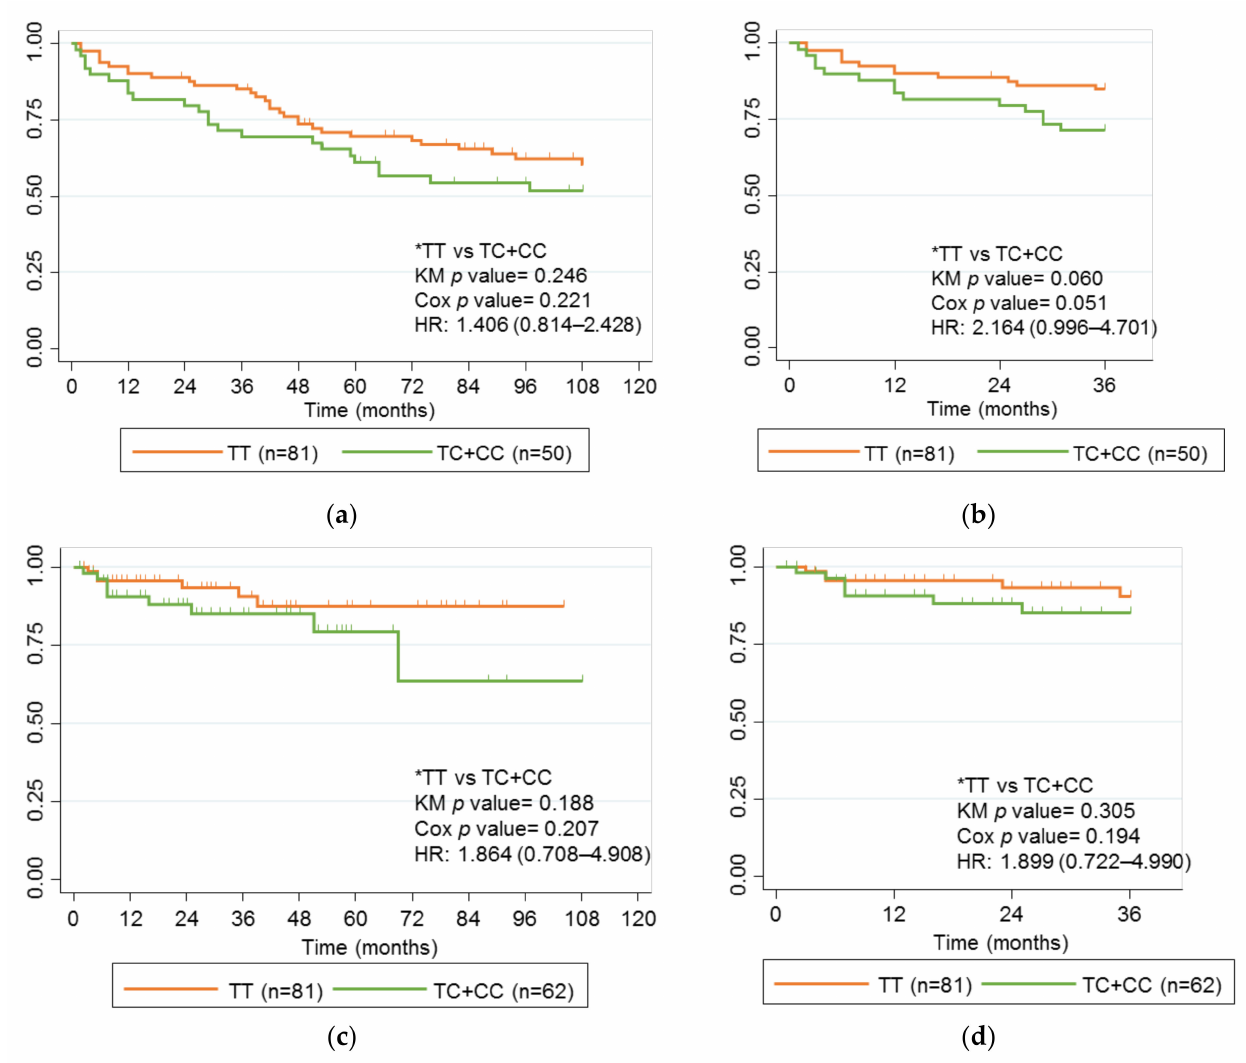
Figure 4. Kaplan-Meier curves for rs2097432 and failure of IFX in children and adults with CD. ( a ) Adults with CD treated with IFX, follow-up 9 years; ( b ) Adults with CD treated with IFX, follow- up 3 years; ( c ) Children with CD treated with IFX, follow-up 9 years; ( d ) Children with CD treated with IFX, follow-up 3 years. Genotype comparisons and p values for the univariate analysis (KM p value) and multivariate analysis (Cox p value) analyses are presented alongside Kaplan-Meier curves. Significant p values are marked in bold. * Reference